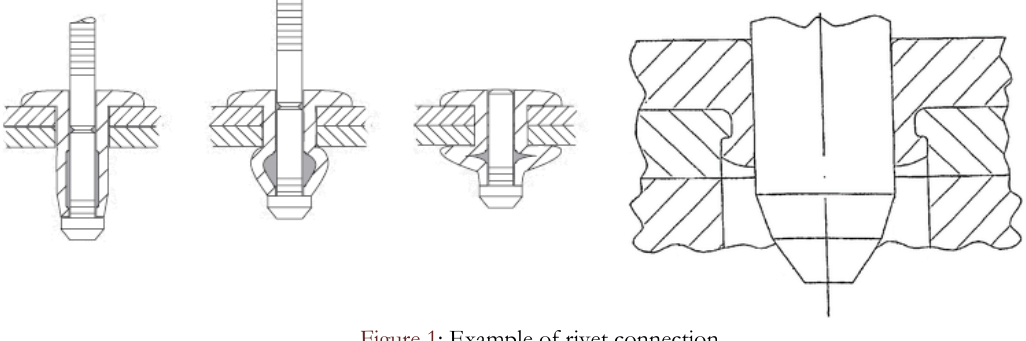
Figure 1: Example of rivet